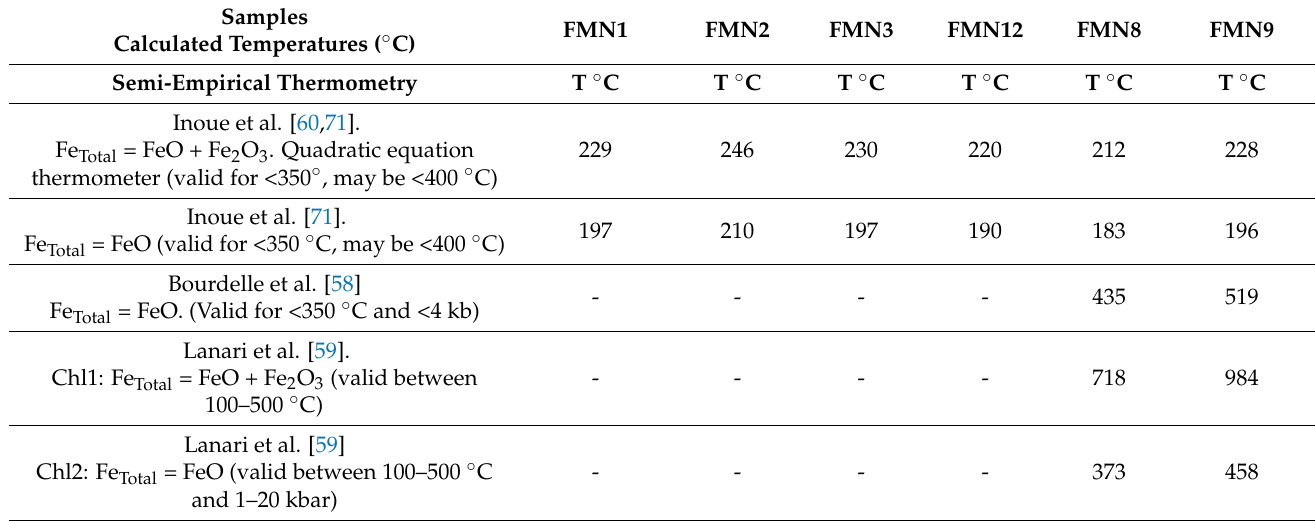
Table 6. Calculated temperatures using semi-empirical